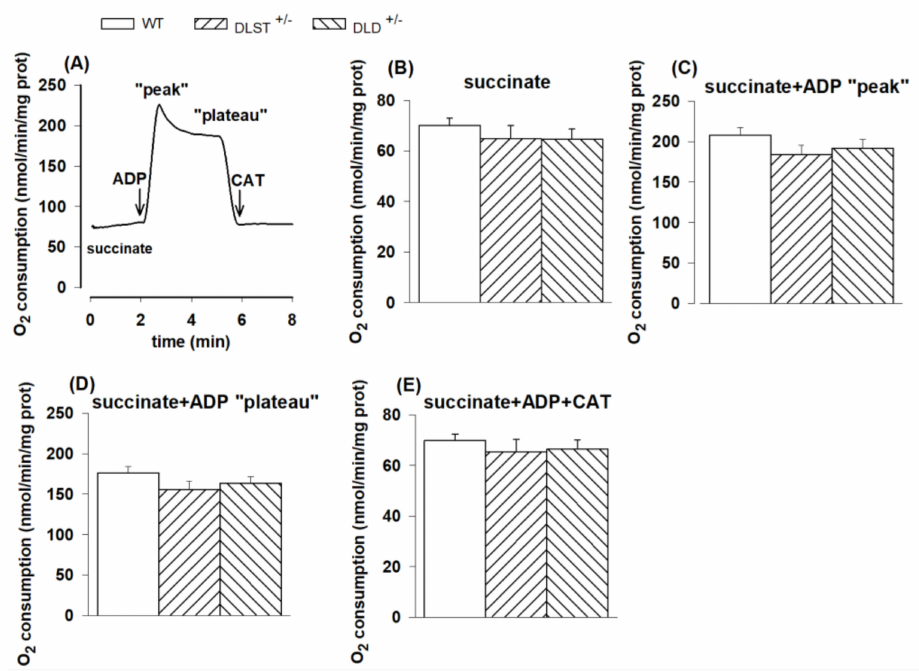
Figure 2. Oxygen consumption of mitochondria isolated from wild-type and KGDHc subunit heterozygote KO mice respiring on succinate in the absence ( B ) or presence ( C , D ) of ADP, and after addition of carboxyatractyloside (CAT), ( E ). ( A ) Trace is representative of a single experiment. Succinate (5 mM), ADP (2 mM); ( C – E ) and CAT (2 µ M); ( E ) were given as indicated. All other conditions and representations are as in Figure 1.